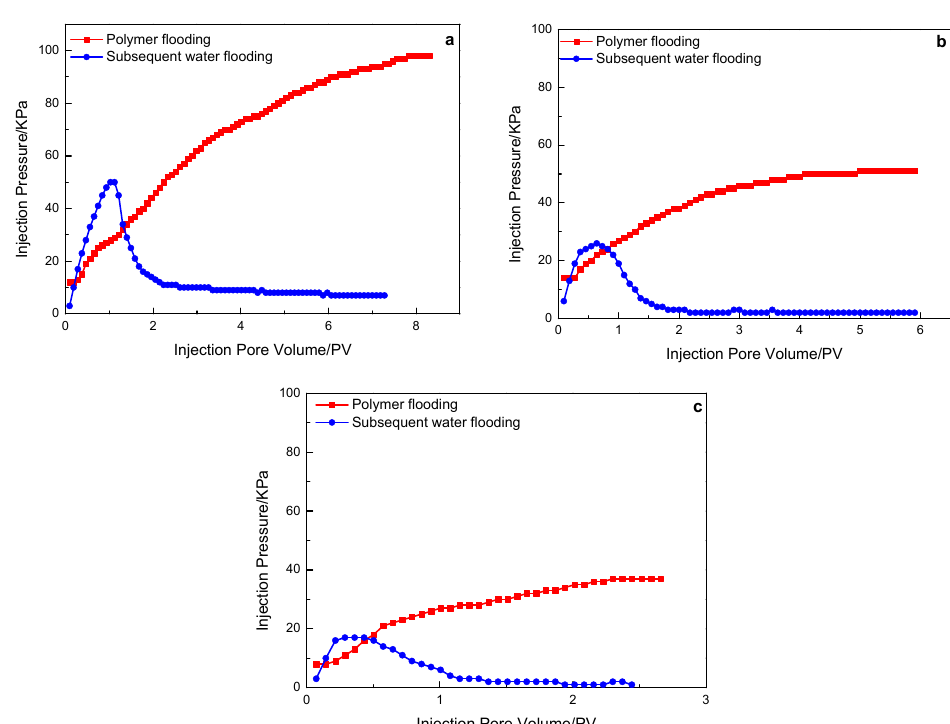
Figure 7. A 19 million molecular weight polymer solution in rock cores with different permeability, the characteristics of the injection pressure of polymer flooding, and subsequent water flooding: ( a ) 500 mD core; ( b ) 1000 mD core; ( c ) 2000 mD core.